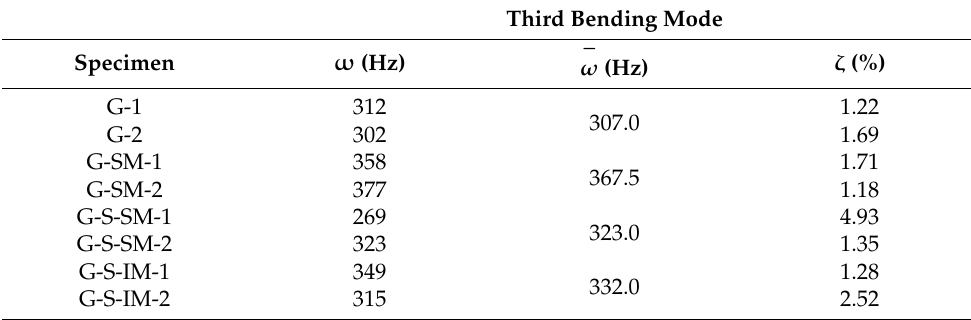
Table 2. Vibration modes, frequencies and damping ratios.